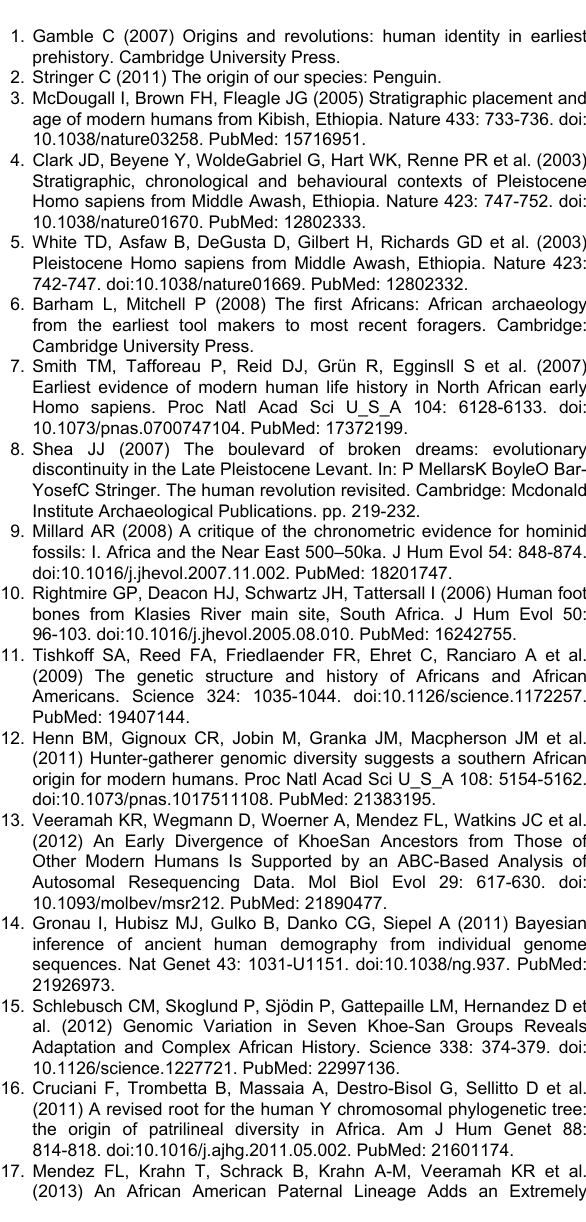
Table S1. HVS-I datasets used in this study. (PDF) Table S2. Description of the complete mitochondrial sequences from haplogroup L0 used in this study. (PDF) Table S3. 224 random sequences used in an overall African mtDNA tree.